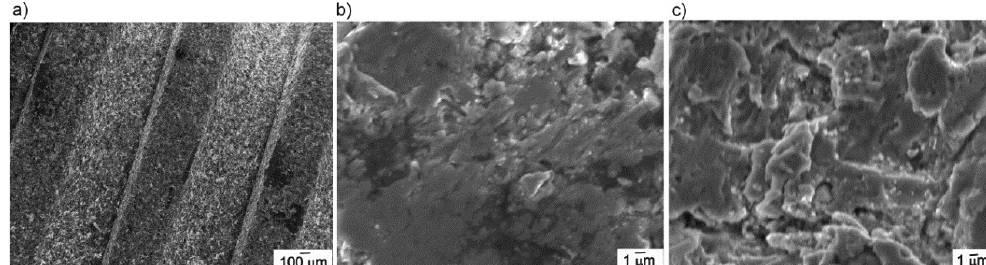
Figure 2. SEM images of the unmodified Ti-implant surface at: ( a ) 50×; ( b ) 3000× and ( c ) of the Ti- implant/bioactive coating surface at 3000× magnification. Ti-implant / bioactive coating surface at 3000 × magnification.